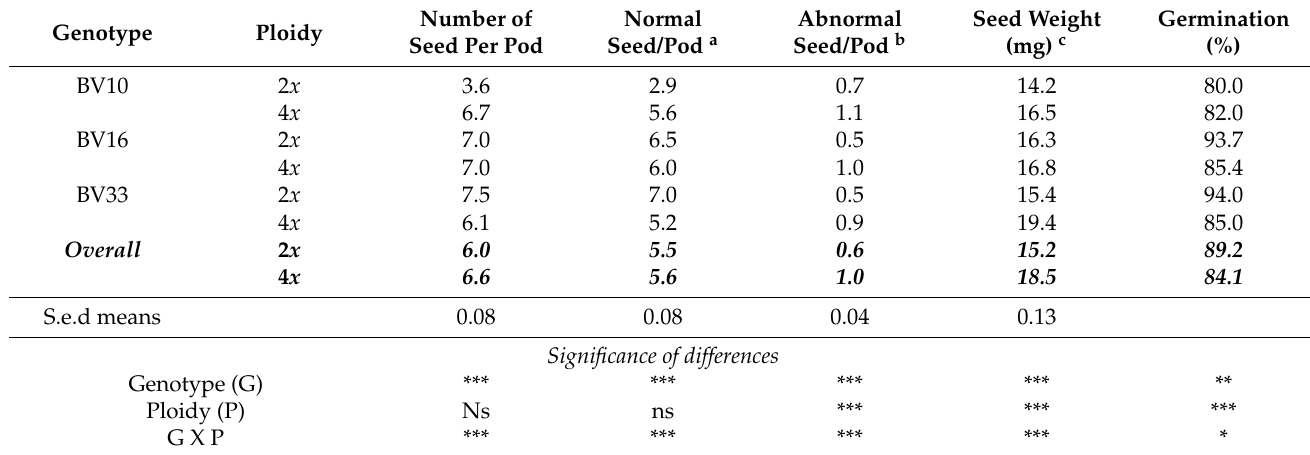
Table 4. Seed parameters and germination from open-pollinated progenies of diploid (2 x ) and tetraploid (4 x ) A. hybrid genotypes (2017